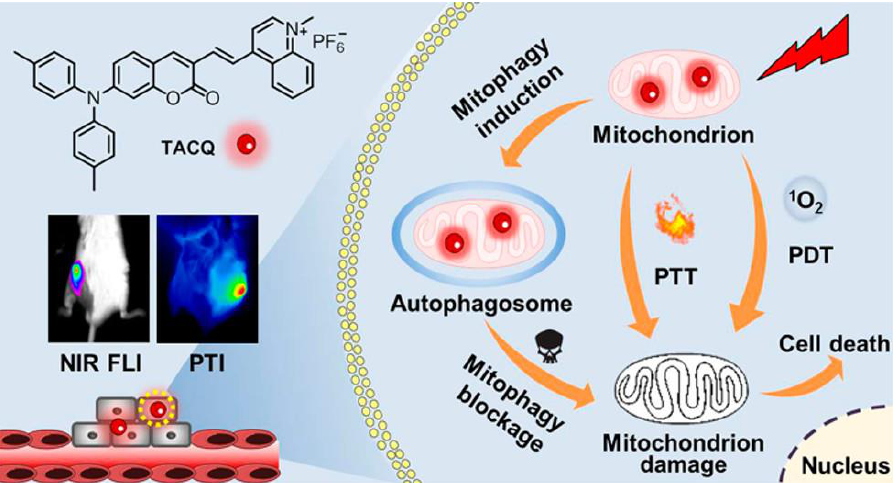
Figure 10. Schematic illustration of chemical structures and multifunctional phototheranostic of TACQ. Reprinted with permission from Ref. [90]. Copyright 2021 American Chemical Society.